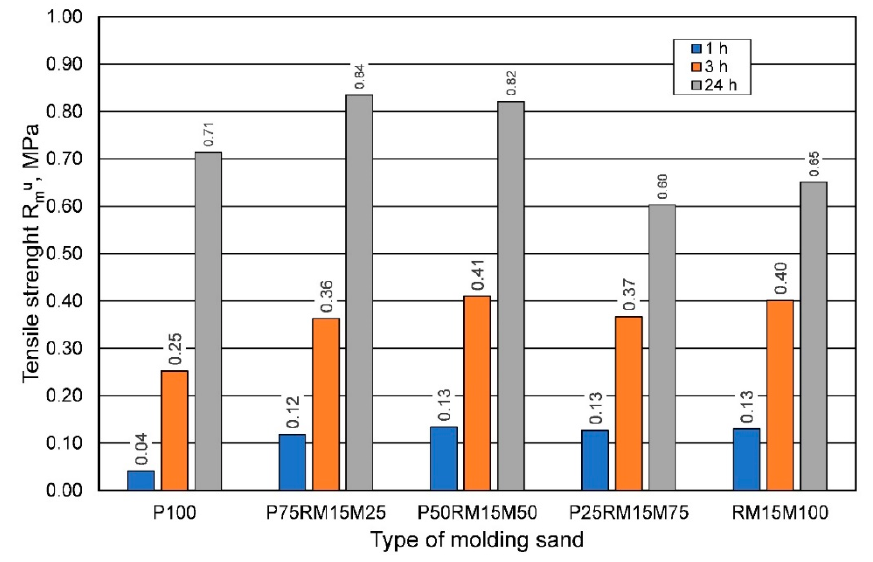
Figure 20. Tensile strength R u m of the molding sand depending on the sand matrix used. A similar dependence can be seen for the bending strength, with higher strengths obtained for the greater share of reclaimed sand in the molding sand than for sand prepared on the fresh matrix (Figure 21).